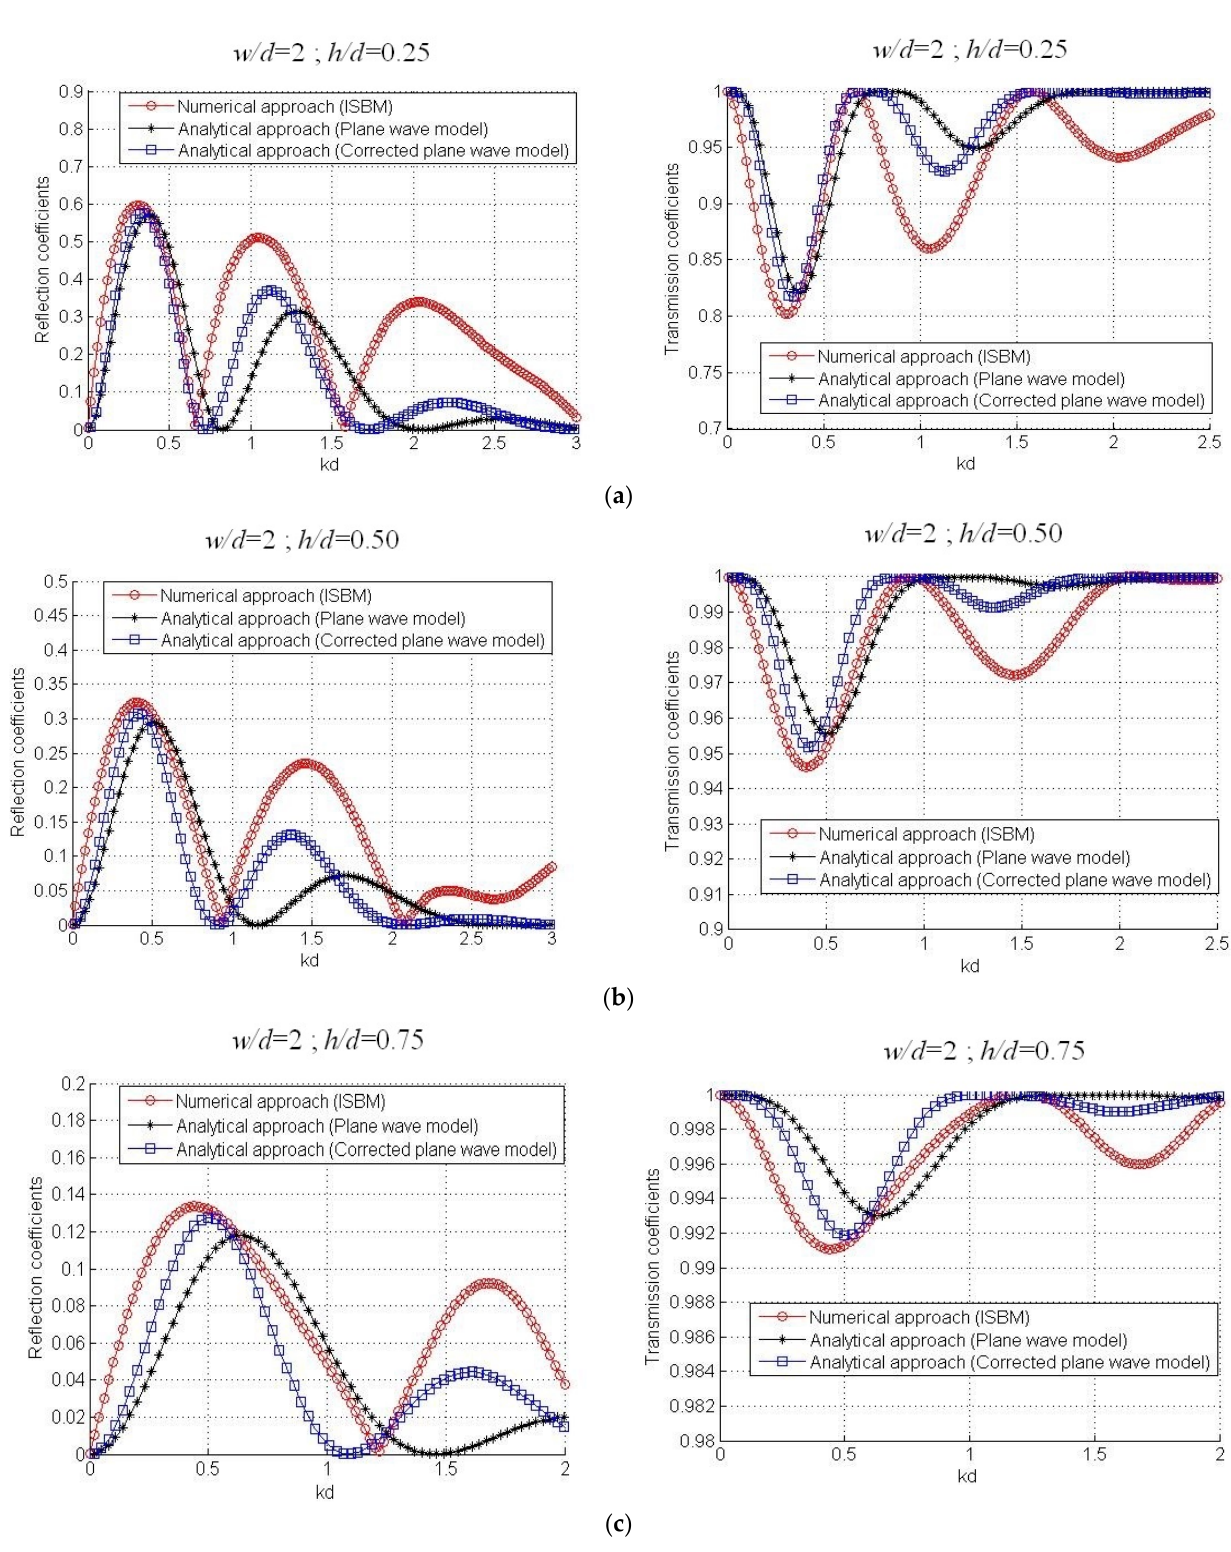
Figure 9. Variations of reflection and transmission coefficients by fixing the relative length at w/d = 2, and varying values of immersion ratio: ( a ) h/d = 0.25, ( b ) h/d = 0.50, ( c ) h/d = 0.75.